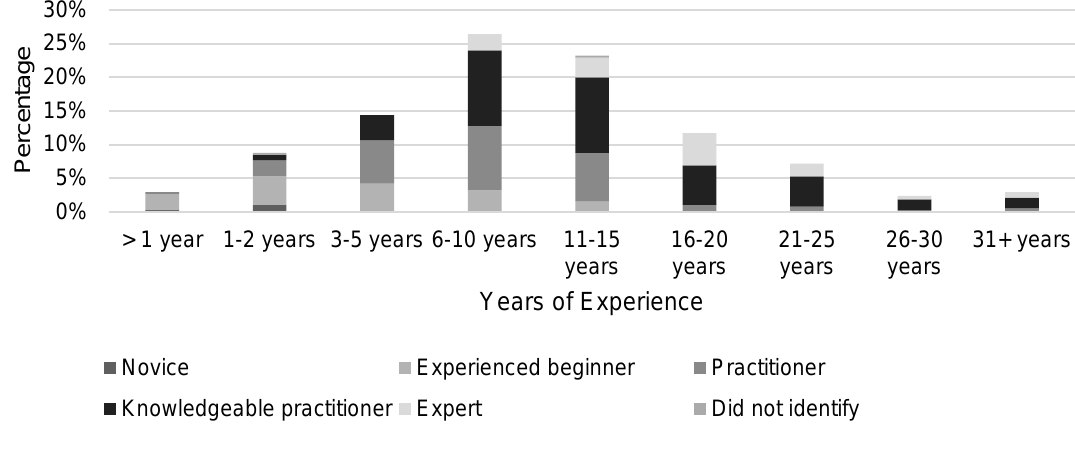
Figure 7. Years of experience and levels of expertise